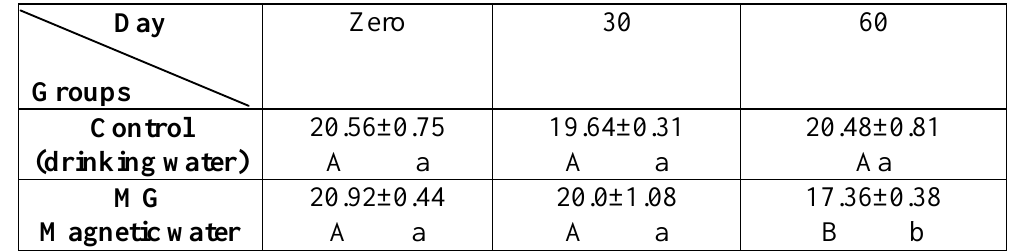
(TAG) concentration (mg\dl) of adult male rabbits. Values are expressed as mean ± SE, n = 5 each group. Capital letters denote differences between groups, P<0.05 vs. control.Small letters denote differences within group. Table (6): Effect of exposure to magnetized water for 60 days on serum very low density lipoprotein - cholesterol (VLDL-C) concentration (mg\dl) of adult male rabbits.